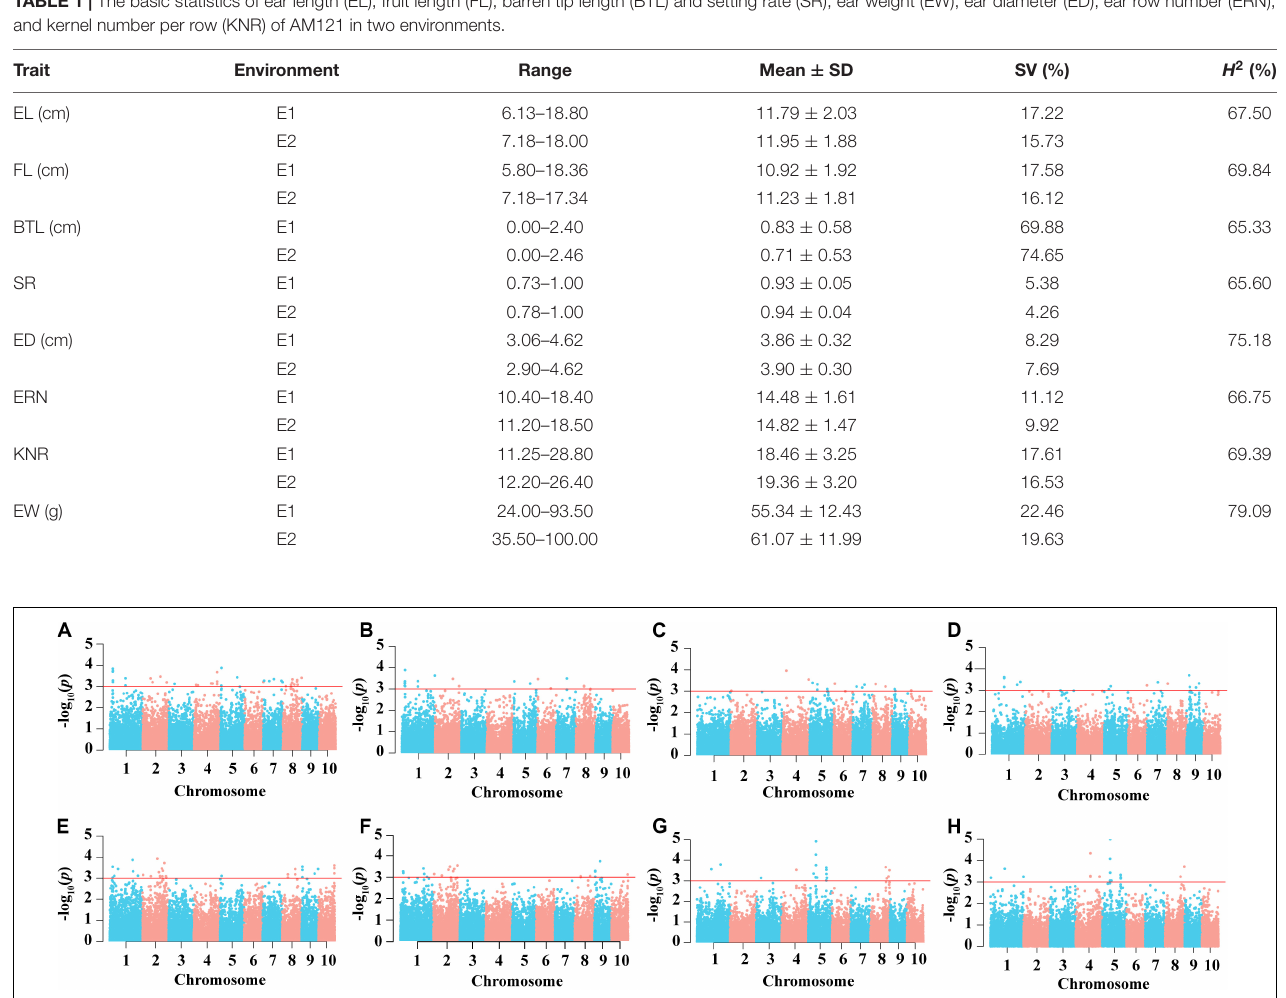
FIGURE 6 | Result of genome-wide association study. Manhattan plots of EL in E1 (A) and in E2 (E) , FL (B) and in E2 (F) , BTL (C) and in E2 (G) and SR in E1 (D) and in E2 (H) .